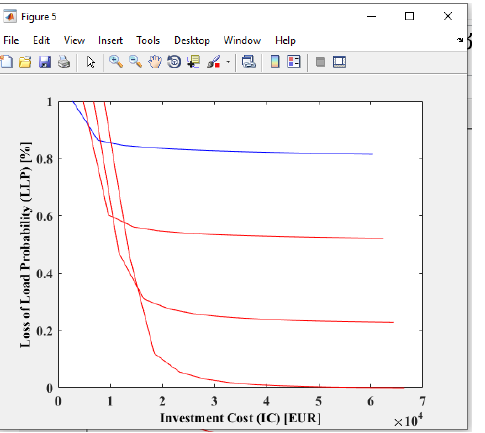
Figure 15. Irradiation and Load at average three hours